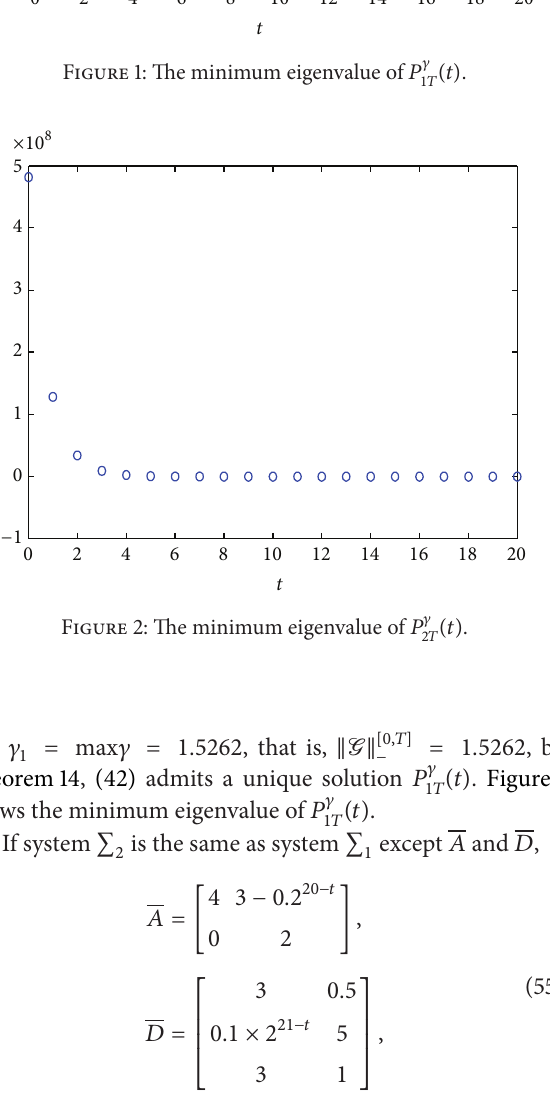
Figure 1: The minimum eigenvalue of 𝑃